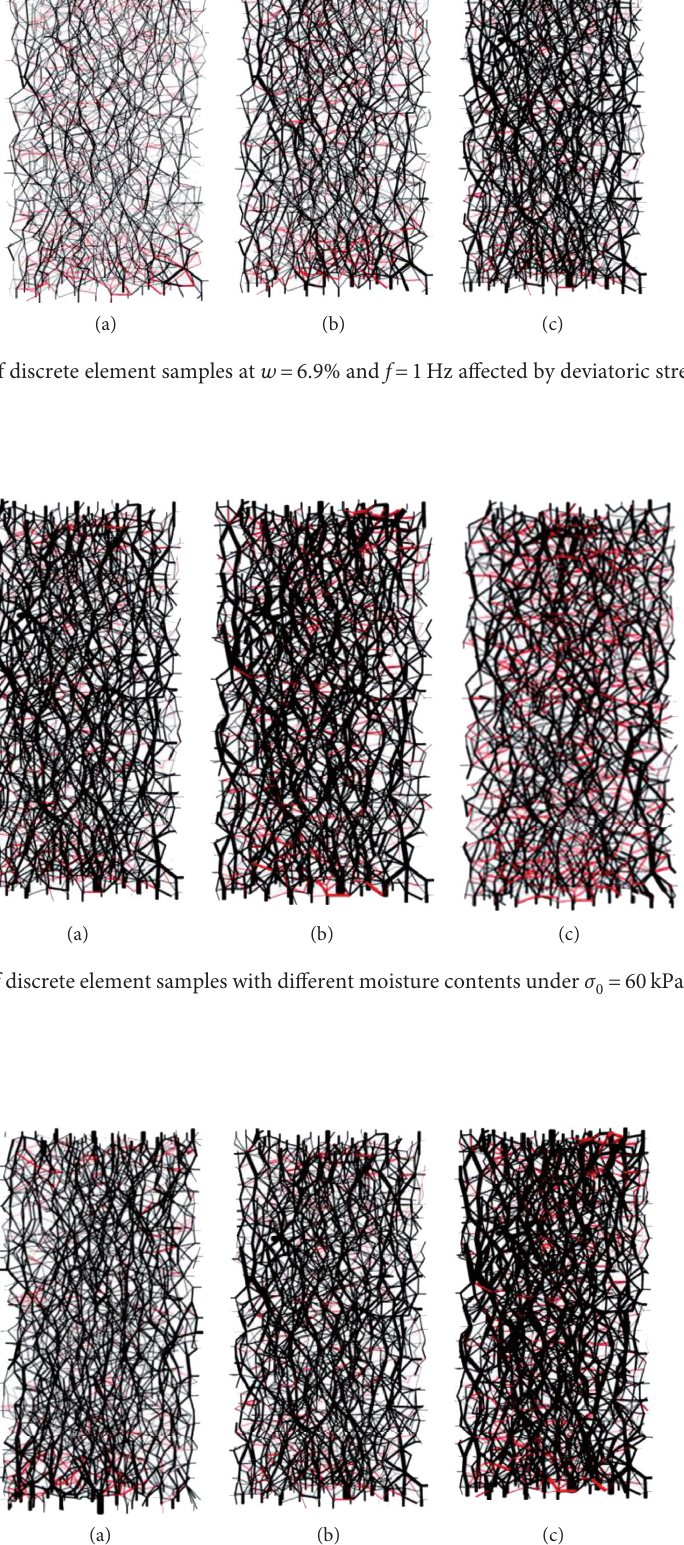
Figure 9: Contact force chains of discrete element samples with w � 6.9% under different loading frequencies and σ (b) f � 1Hz. (c) f � 3Hz.